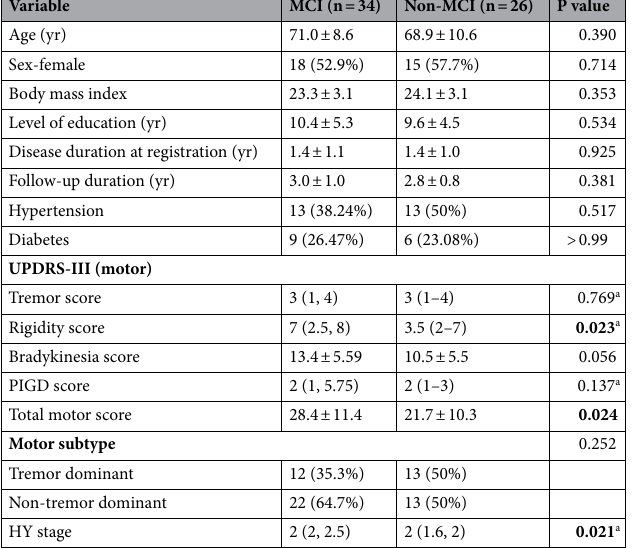
For memory domain as shown in Fig. 1B, compared with 33 patients without memory impairment, 27 patients with memory impairment exhibited higher scores of total motor symptom [median (IQR) of impaired vs. non- impaired: 30 (19.5–38) vs. 24 (13.0–29); p = 0.0291], HY stage [median (IQR) of impaired vs. non-impaired: 2.5 (2–2.5) vs. 2.0 (2–2.0); p = 0.0018], and total dysautonomia [median (IQR) of impaired vs. non-impaired: 18